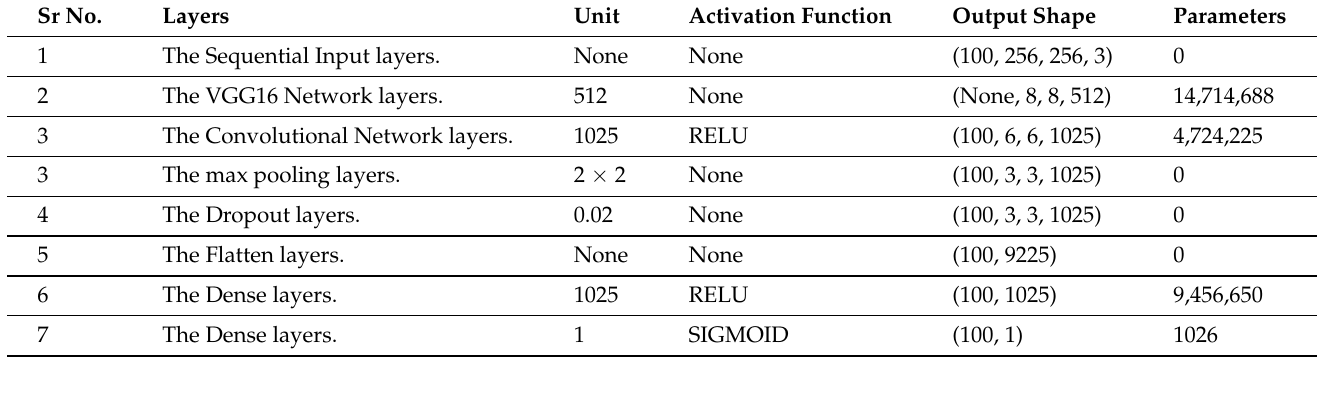
Table 6. The novel proposed DFP model configuration parameters analysis.